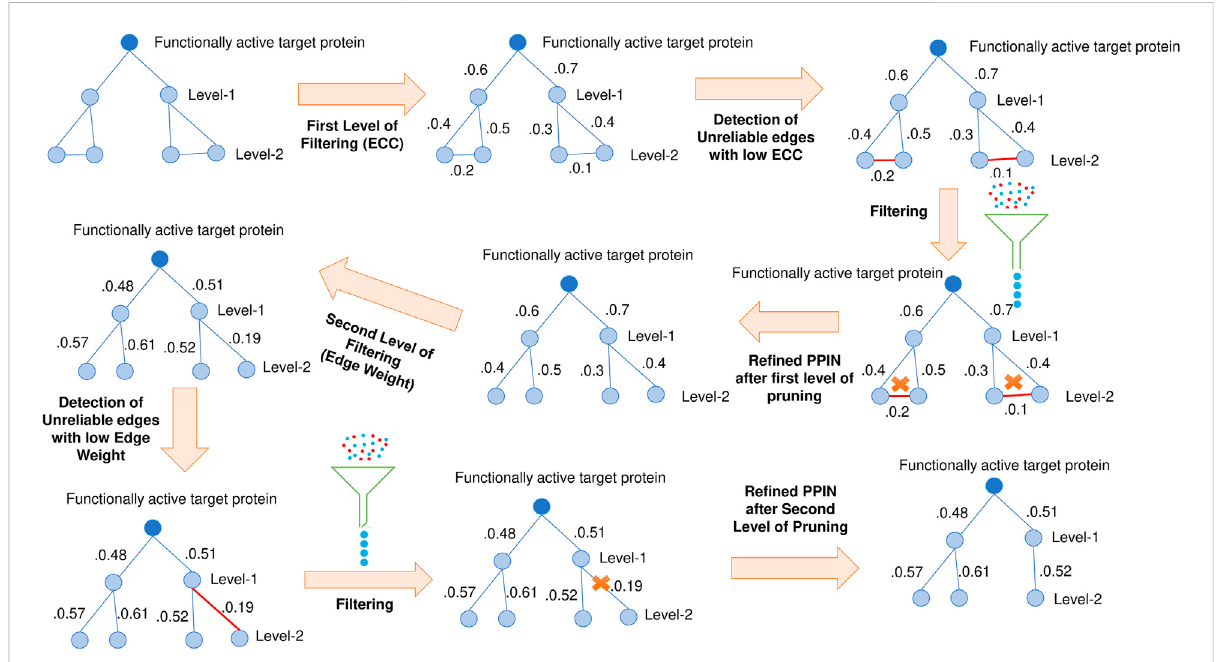
FIGURE 3 Double fi lteringoftargetneighborhoodgraph.Edgeclusteringcoef fi cientandedgeweightarecomputedbasedonwhichnon-essentialnodes are fi